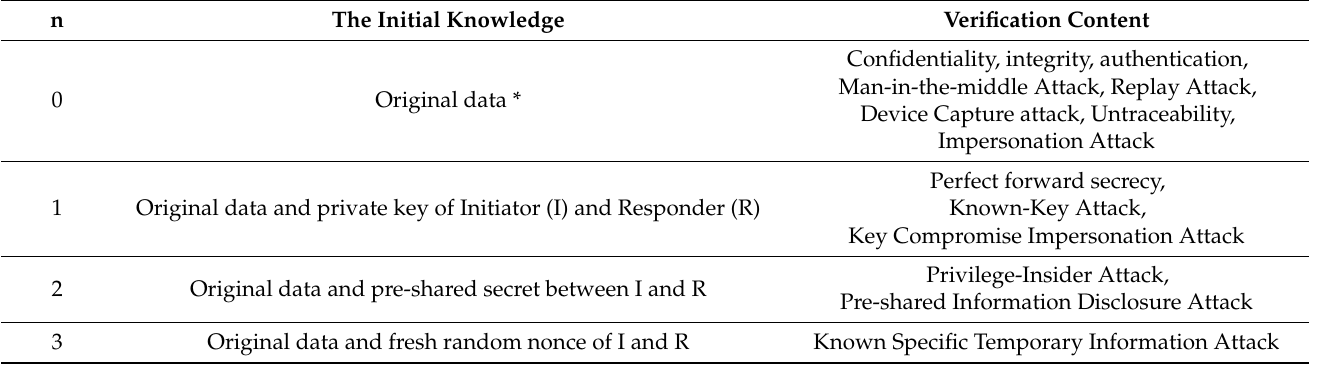
Table 3. Adversary knowledge base initial parameters and verification content.